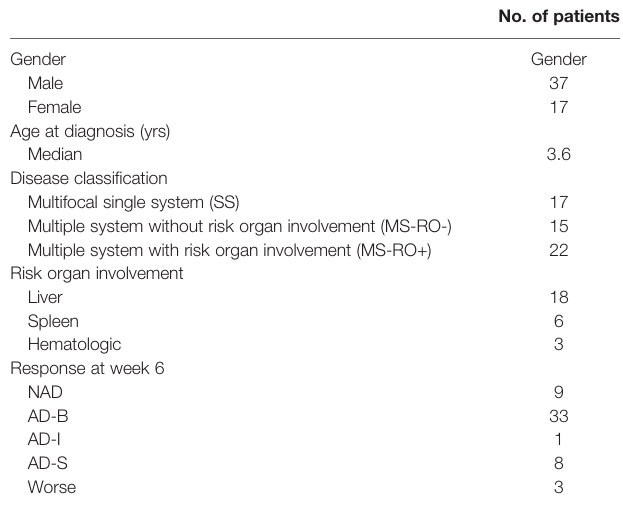
TABLE 1 | Clinical characteristics of 54 children with